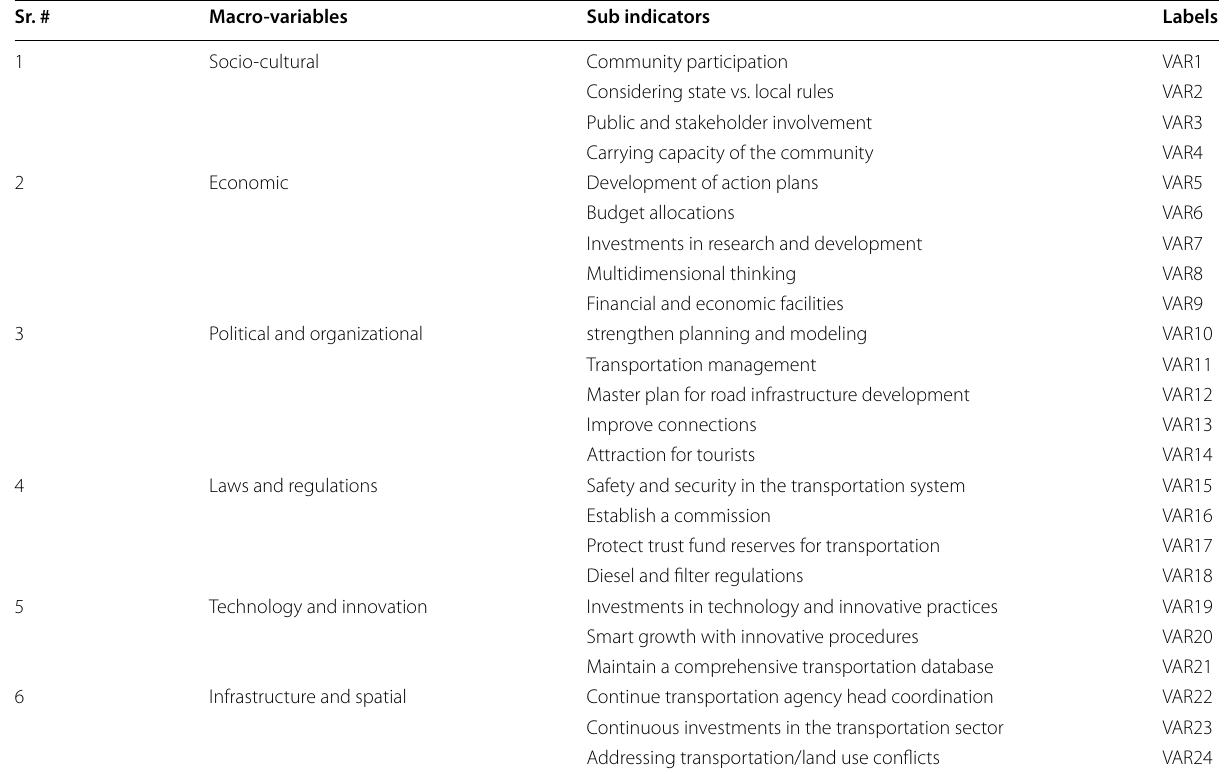
Table 1 Study variables and sub-indicators Sr. #